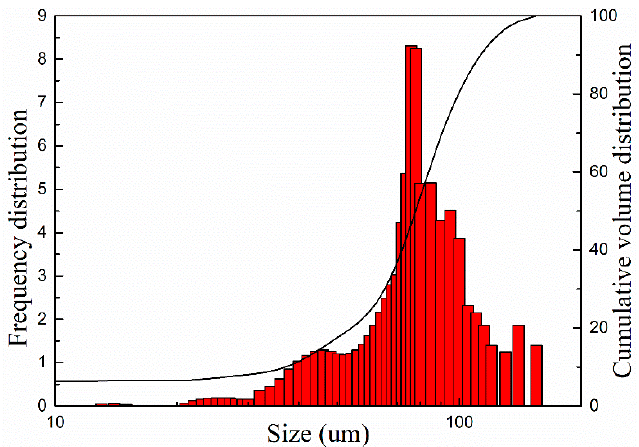
Figure 1. The particle size distribution diagram of TH 2